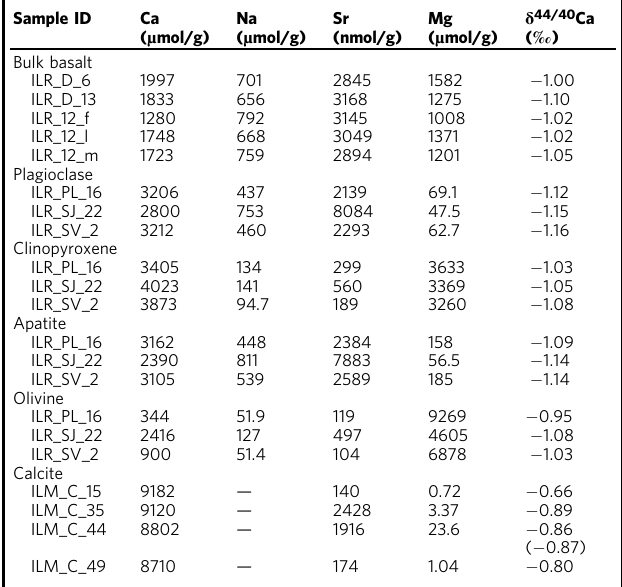
Table 1 Elemental and Ca isotope data for bulk basalt, primary mineral separates, and